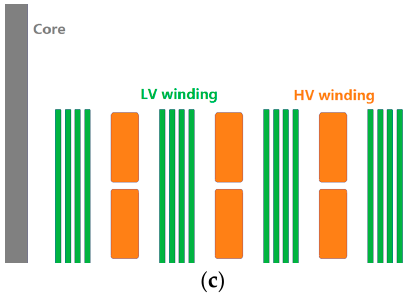
Figure 8. Winding arrangements (partial) for three windings: ( a ) Non-interleaved winding N-1; ( b ) Interleaved winding I-1; ( c ) Interleaved winding I-2.